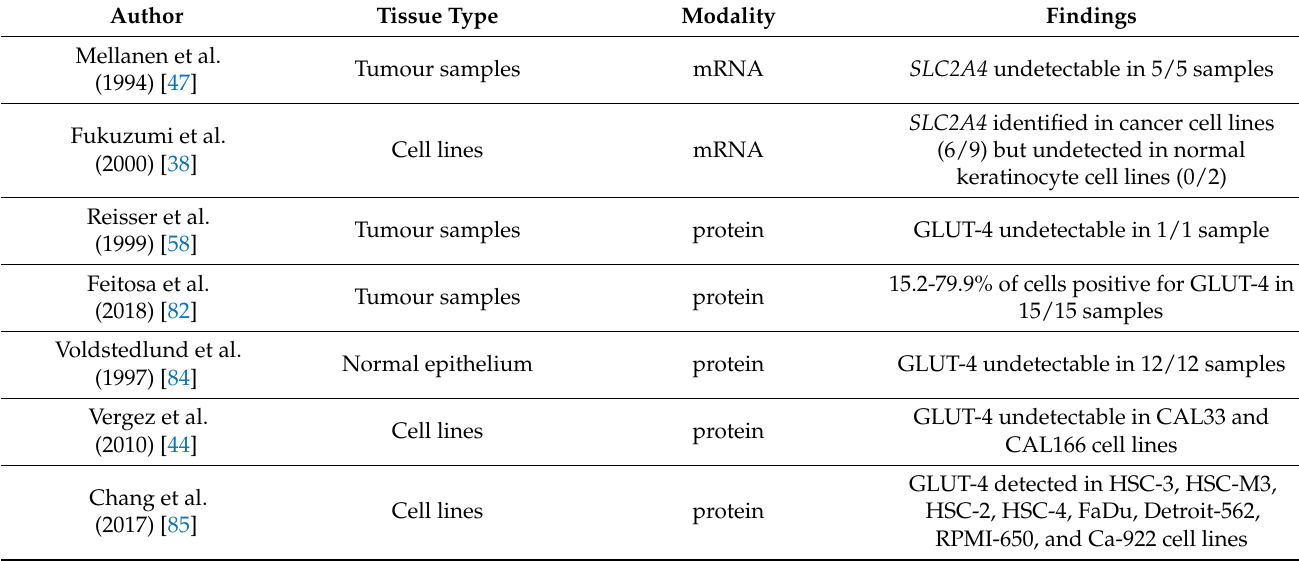
Table 4. Summary of findings for